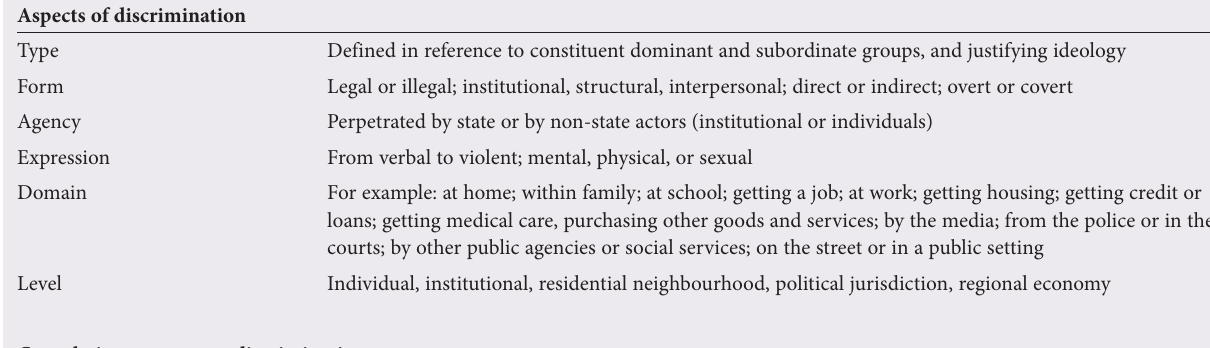
Table 1. Conceptualising discrimination as a determinant of population health Aspects of